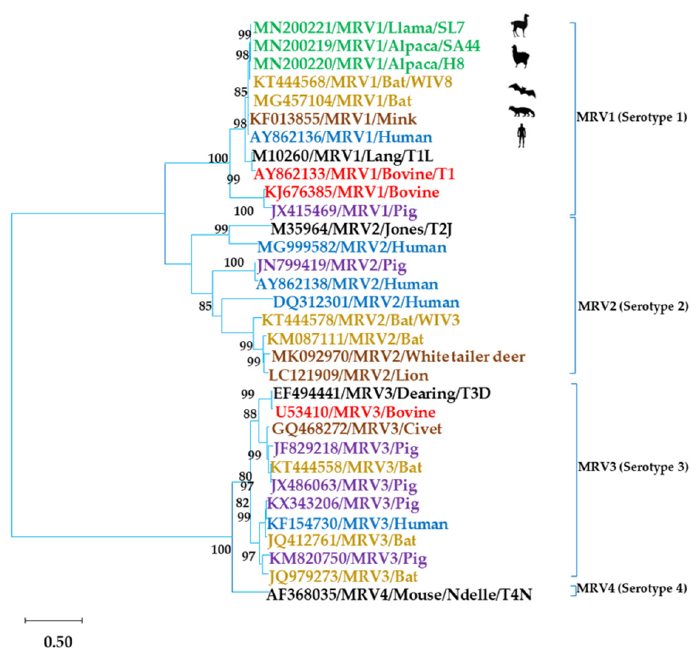
Figure 2. Phylogenetic trees constructed from partial nucleotide sequences (1069 bp) of the sigma 1 gene from MRV strains. Distances were corrected with the GTR-G model. Phylogenetic trees were constructed using the maximum likelihood method. Statistical support was provided by bootstrapping 1000 pseudoreplicates. Bootstrap values > 75% are given at branch nodes. The distance scale reflects substitutions/site. Reference samples are identified by GenBank accession numbers. In black, reference strains for each